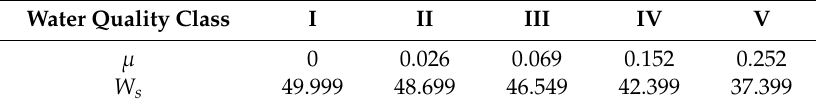
Table 5. SW quantity in di ff erent water quality class (million m 3